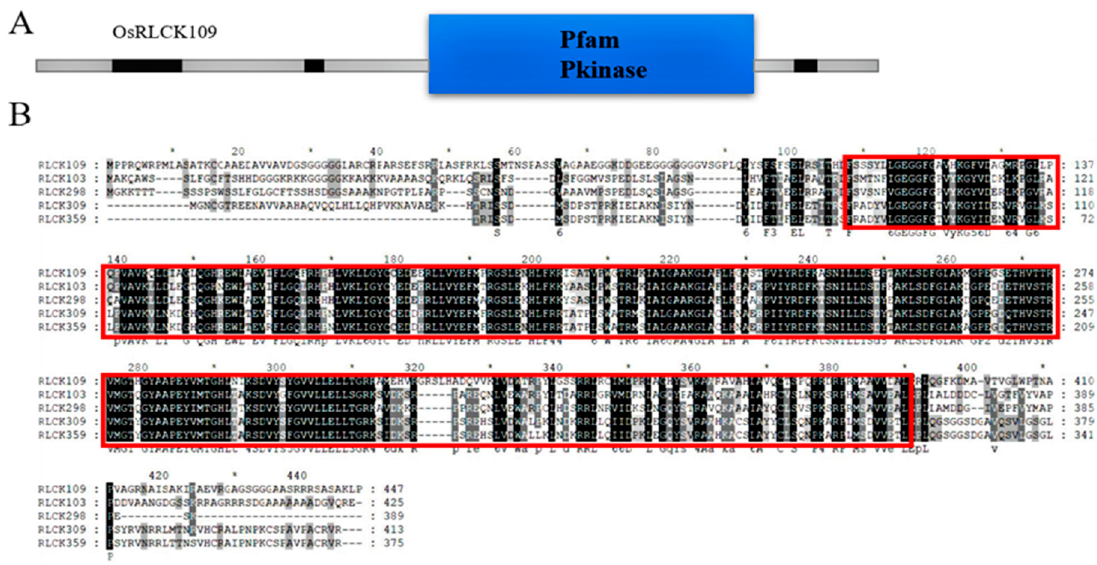
Figure 7. Predicted domains of OsRLCK109 and multiple sequence alignment. ( A ) Prediction of OsRLCK109 protein domains on smart website, blue rectangular region indicates the kinase domain. ( B ) Protein sequence alignment of OsRLCK109 and four other RLCKs, the highly conserved kinase domain is shown in the red box.